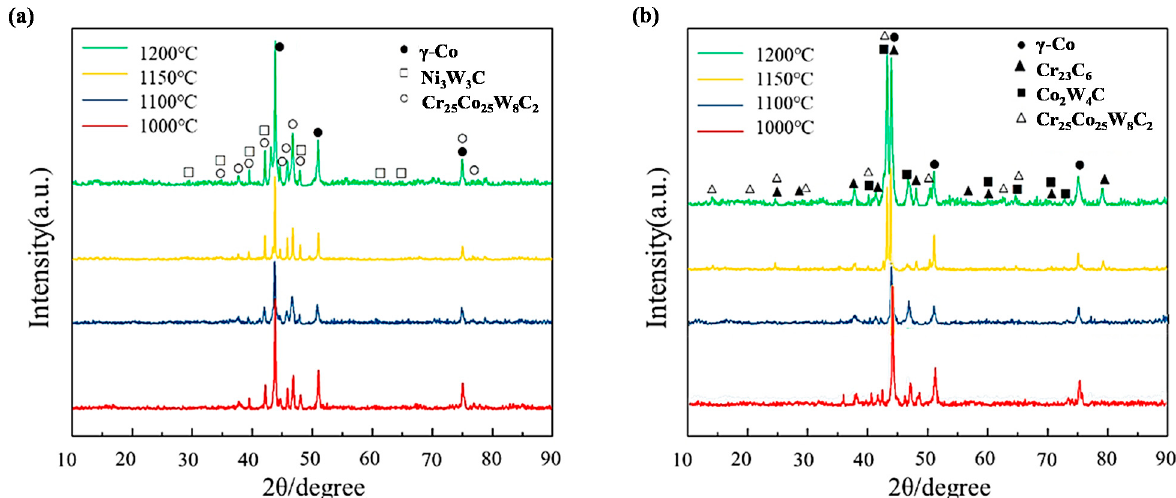
Figure 6. XRD patterns of the Co–Cr–W alloy and the Co–Cr–W matrix composites. ( a ) Co–Cr–W alloy; ( b ) Co–Cr–W matrix composites.